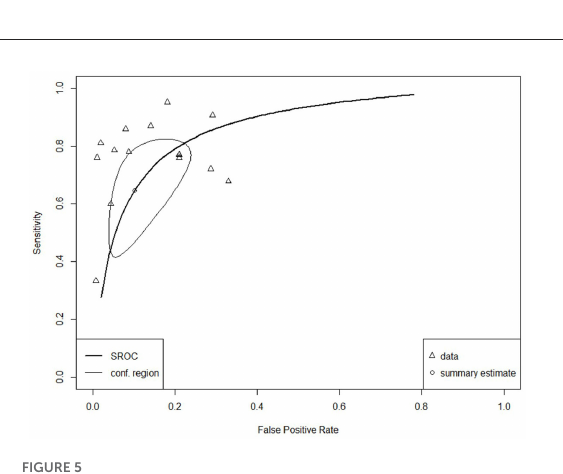
FIGURE5 SROC curve for structured data ( n =